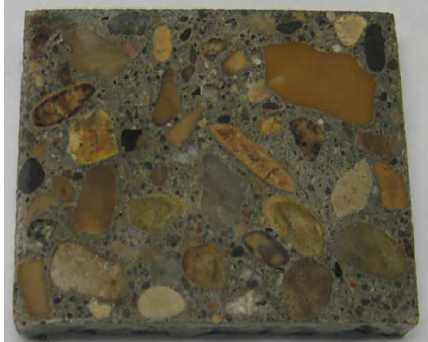
Figure 6: Saw cut slice sample from concrete beam.